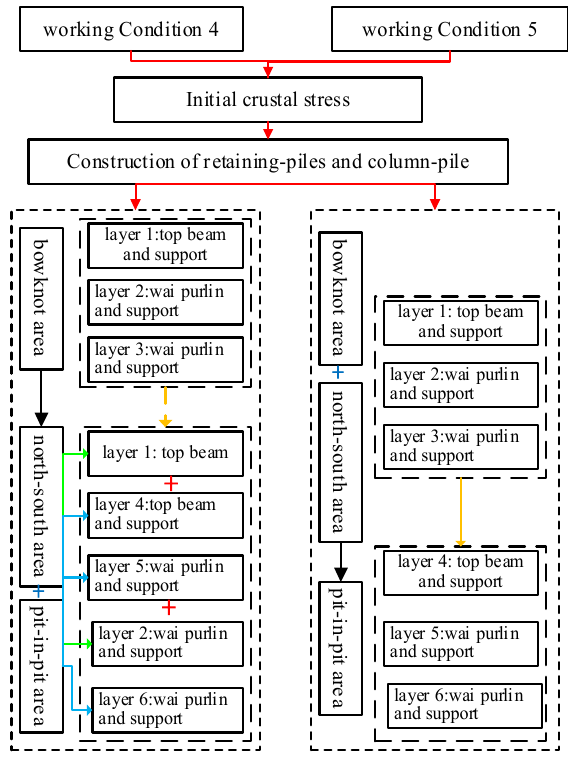
Figure 15. Simulation calculation of conditions.